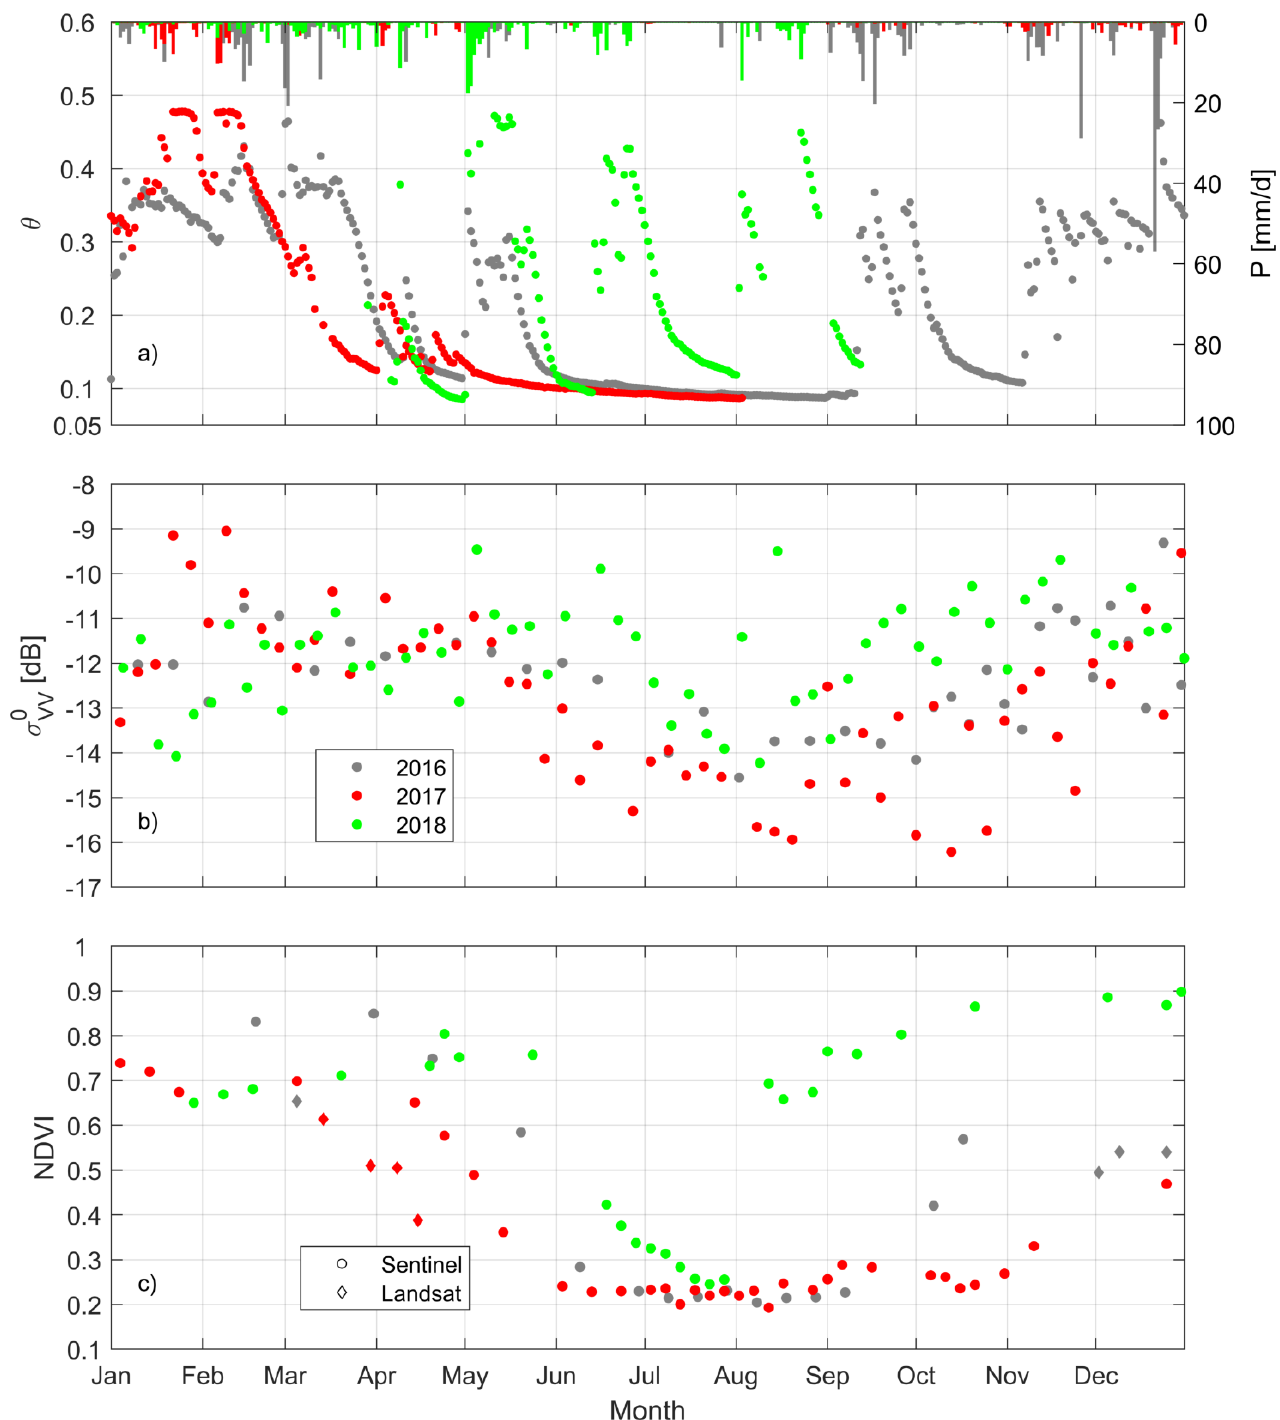
Figure 1. Daily time series at the Sardinian grass field during the 2016–2018 period of ( a ) observed soil moisture ( θ ) and precipitation (P), ( b ) radar backscattering in VV polarization ( σ o vv ) from the Sentinel 1 satellite, ( c ) normalized difference vegetation index (NDVI) estimated from the Sentinel 2 satellite (note that few a NDVI from Landsat were used to improve the NDVI time series).